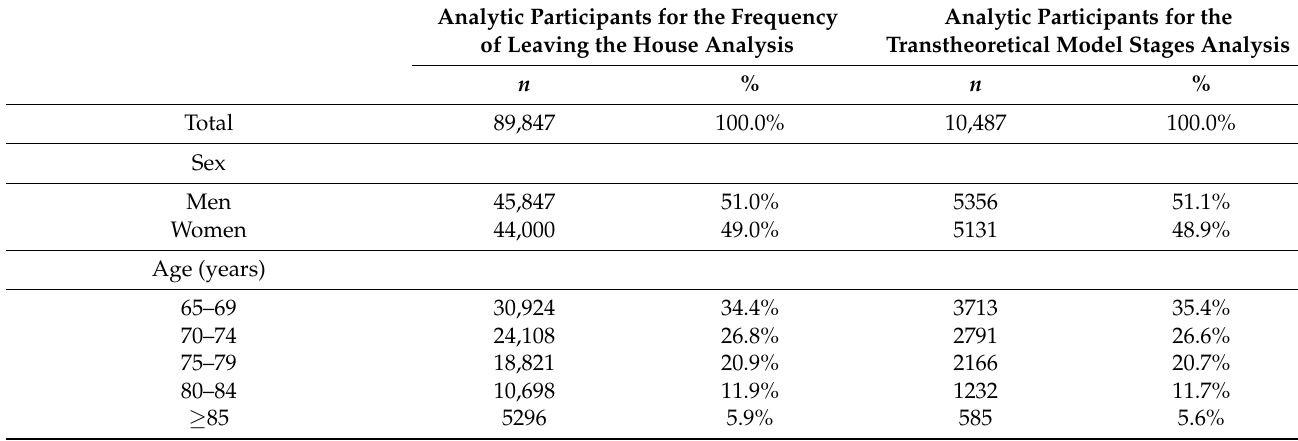
Table 1. Characteristics of the participants.